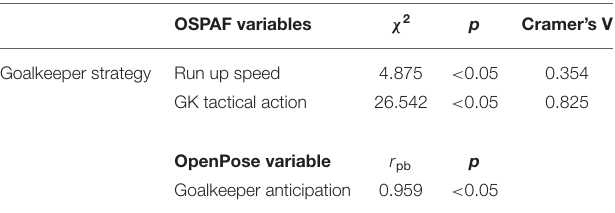
TABLE 4 | Association between OSPAF and OpenPose variables with the goalkeeper strategy.